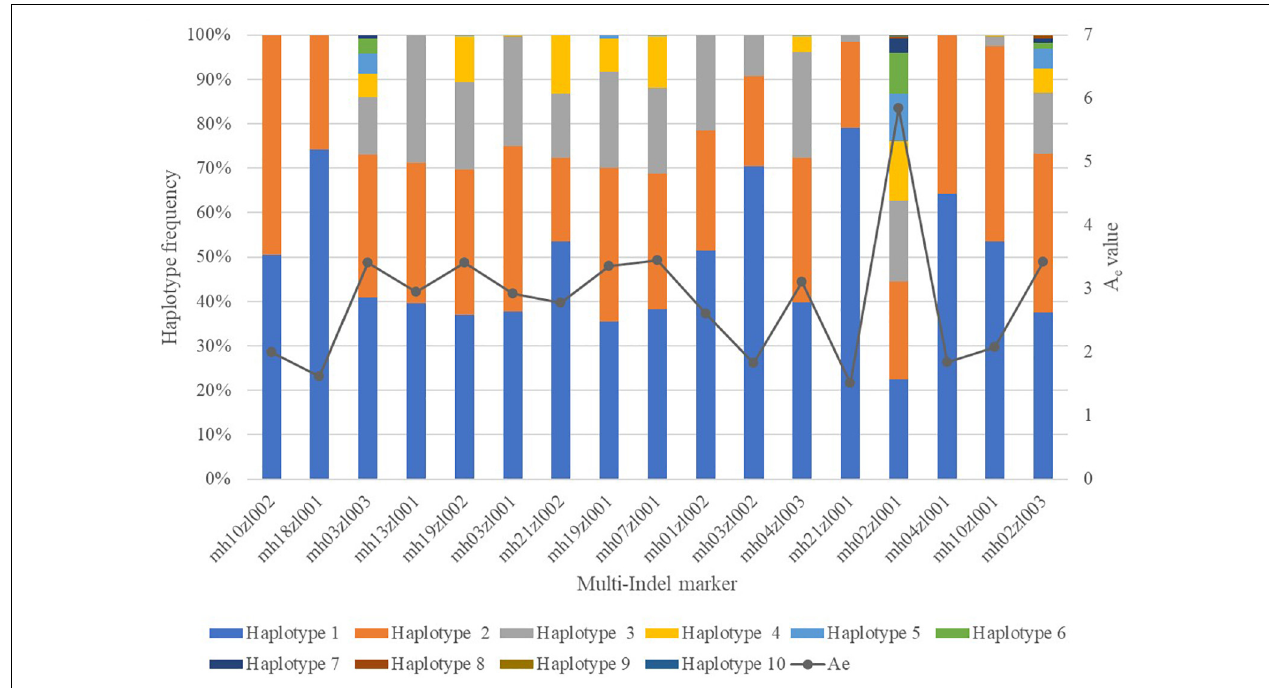
FIGURE 6 | Effective numbers of alleles (A e ) and haplotype frequencies of 17 multi-Indel markers. TABLE 2 | Values for PD, PE, Ho, PM, PIC, TPI, and HWE of a 17 multi-Indel marker.